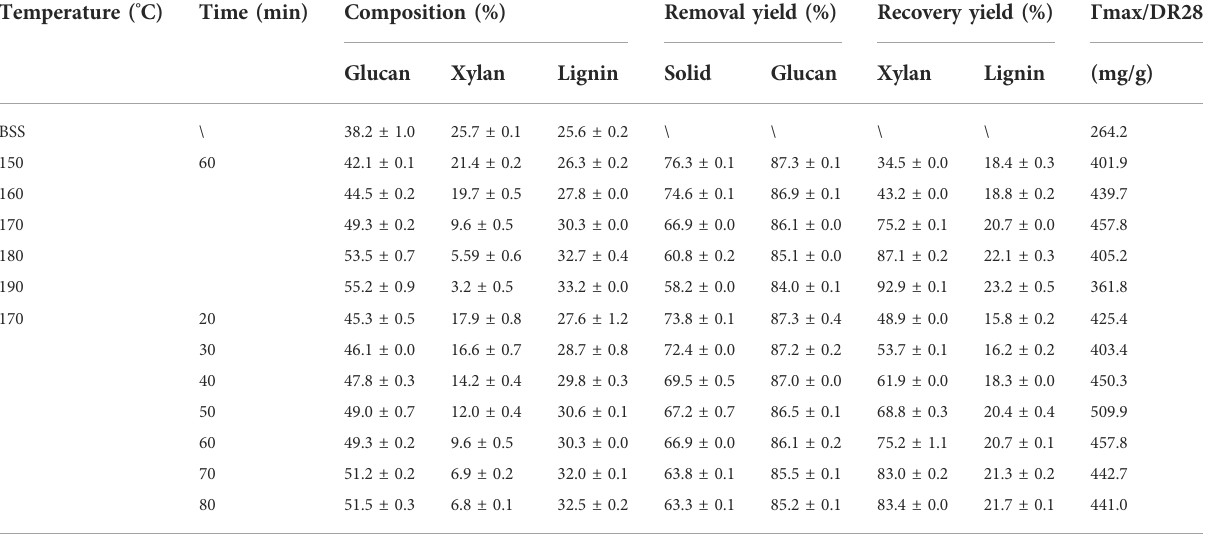
TABLE 1 Compositions of the BSS residue after